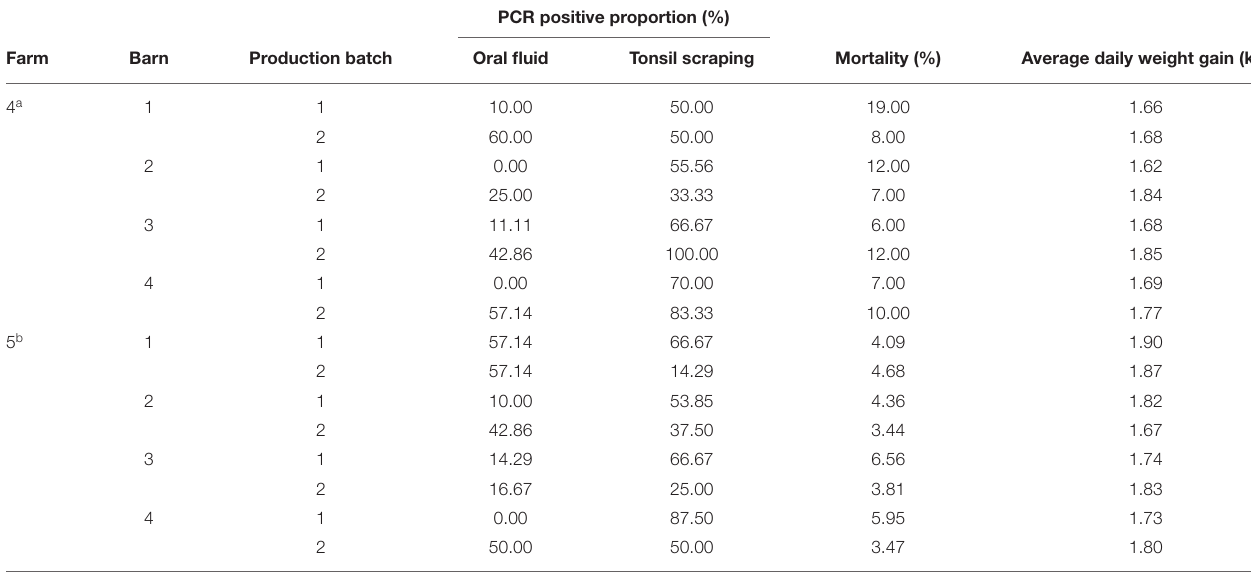
a Farm4.LatestPRRSVoutbreak, < 1monthpriortothefirstsamplingevent.Productionbatch1occurredApril–September2019andproductionbatch2October2019–February2020. b Farm 5. Vaccinated with a modified live vaccine (Ingelvac PRRS ® MLV, Boehringer Ingelheim). Production batch 1 occurred April–October 2019 and production batch 2